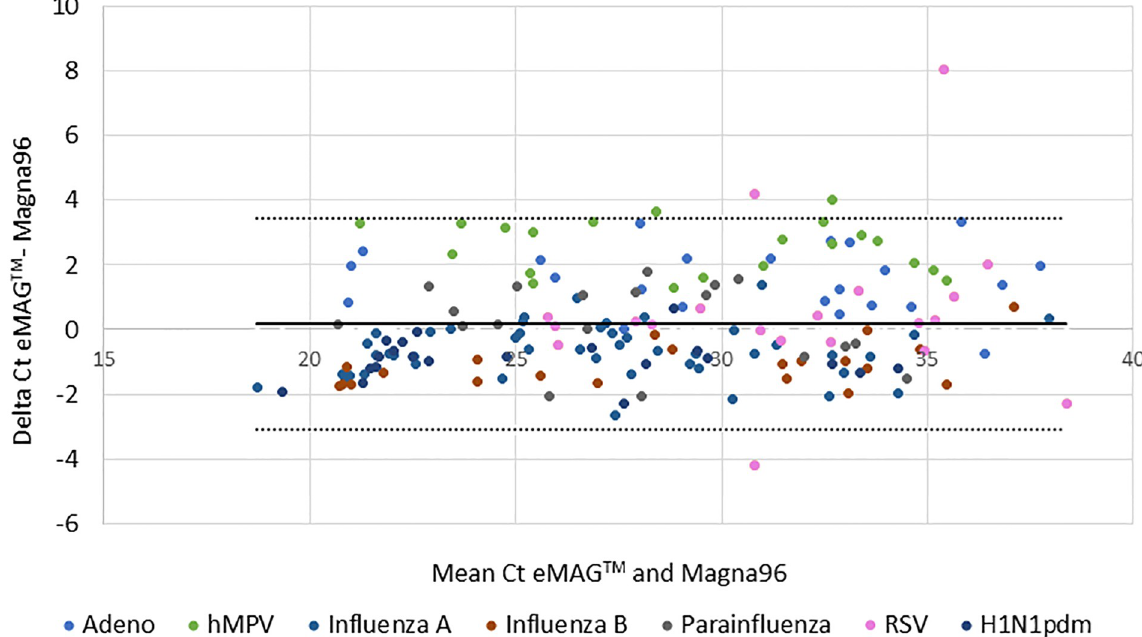
Fig 1. Bland-Altman analysis of the quantitative results of eMAG versus MagNA PURE 96. Bland-Altman analysis was performed on all samples for all the viruses examined, to compare the Ct values measured between eMAG and the MagNA PURE 96. The y-axis presents the delta Ct between the two platforms, while the x-axis presents the mean Ct value for both platforms for each sample. 2 SD borders are shown.